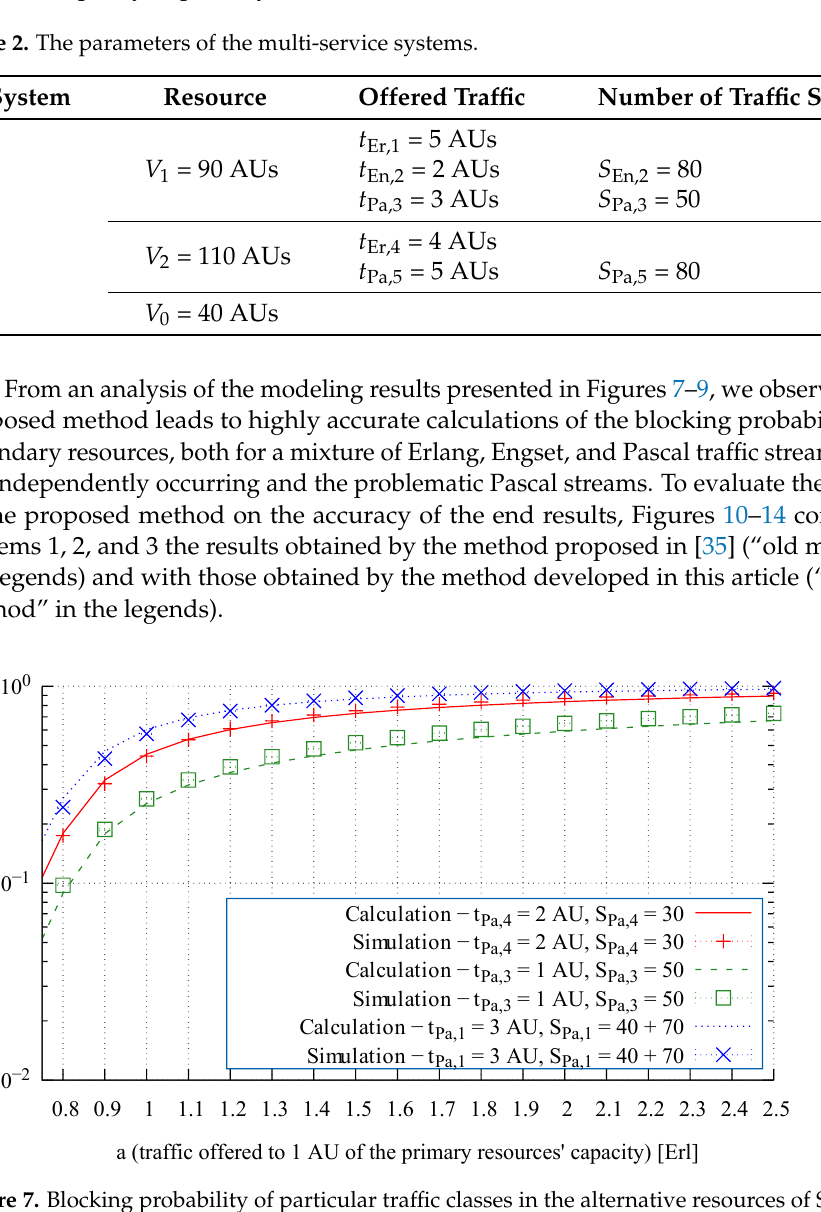
Figure 7. Blocking probability of particular traffic classes in the alternative resources of System